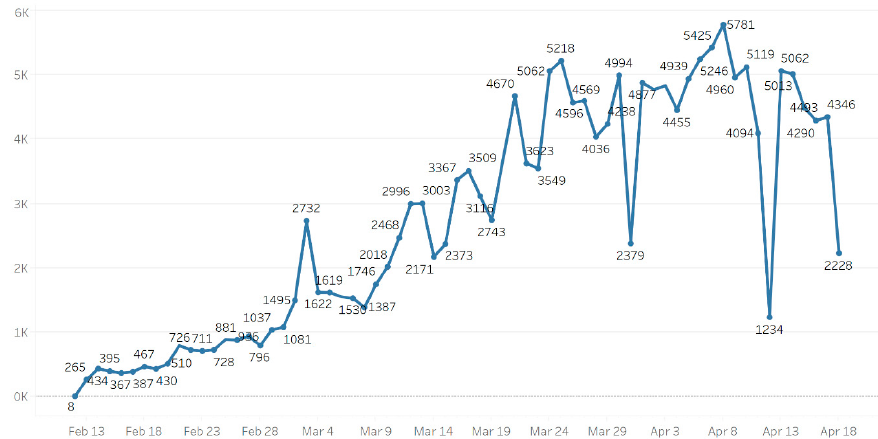
Figure 1. Frequency of bots’ tweets referencing COVID-19 from February 12 to 18 April 2020.